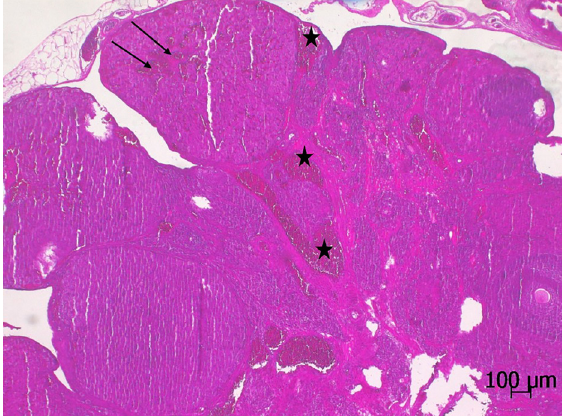
Figure 3. Ovarian tissue of the animal group subjected to sham operation (SG) displays corpus luteum (star) and follicular structures (arrows) (H&E).